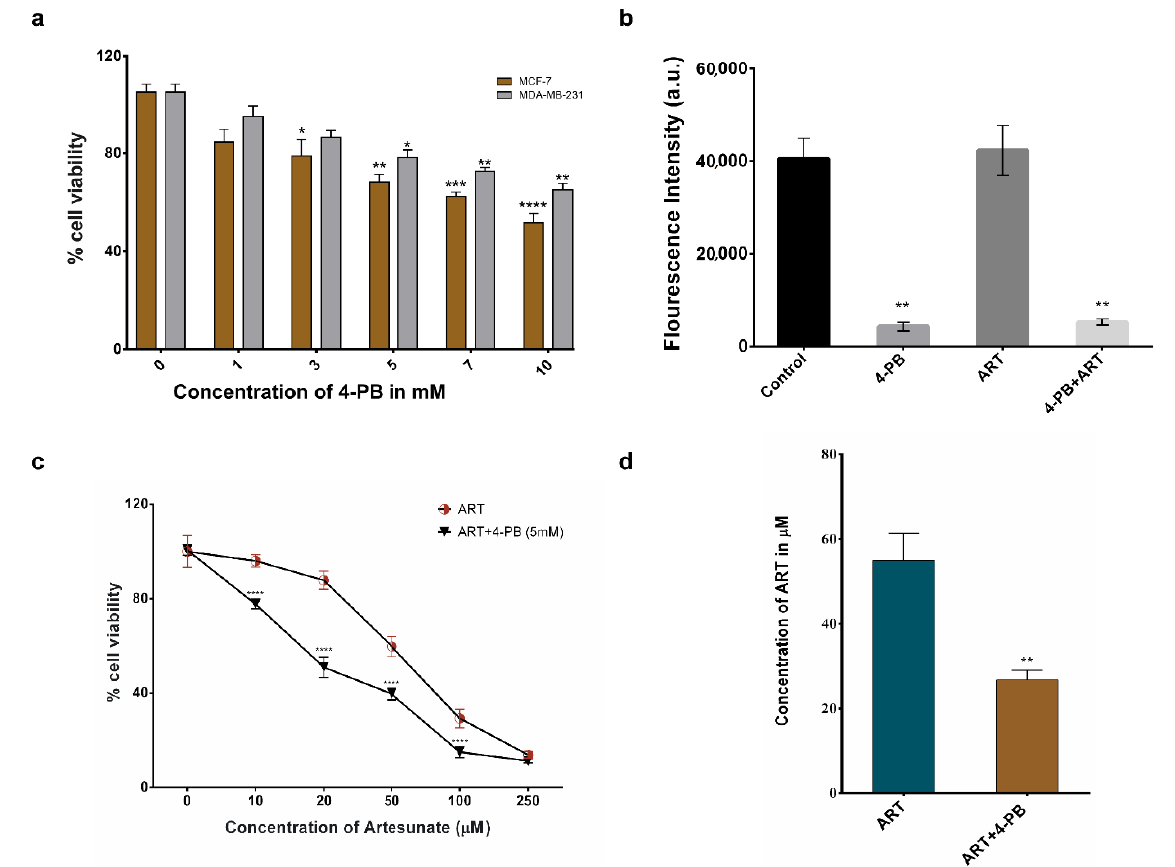
Figure 1. Dose dependent cell viability and HDAC inhibition assay. ( a ) Reduction in cell viability was assessed after treating MCF-7 and MDA-MB-231 cells with different concentrations of 4-PB. ( b ) 4-PB acted by inhibiting HDAC activity in MCF-7 cells. ( c ) Dose dependent cell viability of ART and in combination with 5 mM 4-PB was examined by MTT based cell viability assay. ( d ) IC 50 value of ART and ART in combination with 5 mM 4-PB was calculated using non-linear curve regression analysis and the level of significance were calculated using unpaired two tailed t -test ( n = 3, p = 0.0020). Data are represented as mean ± SD ( n = 4) in all the graphs. * p < 0.05, ** p < 0.01, *** p < 0.001 and **** p < 0.0001.